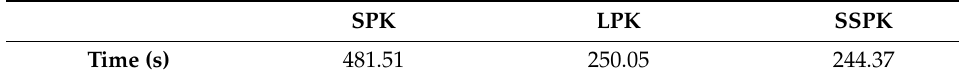
Table 4. Computational time for the second case